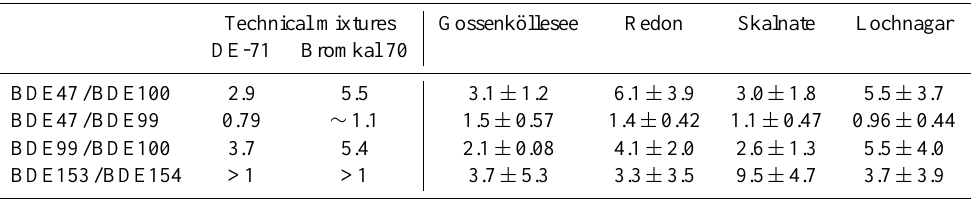
Table 6. Mean PBDE ratios in pentaBDE technical mixtures and atmospheric deposition samples from remote regions of Europe. Technical mixture data from La Guardia et al. (2006) and Sjödin et al.